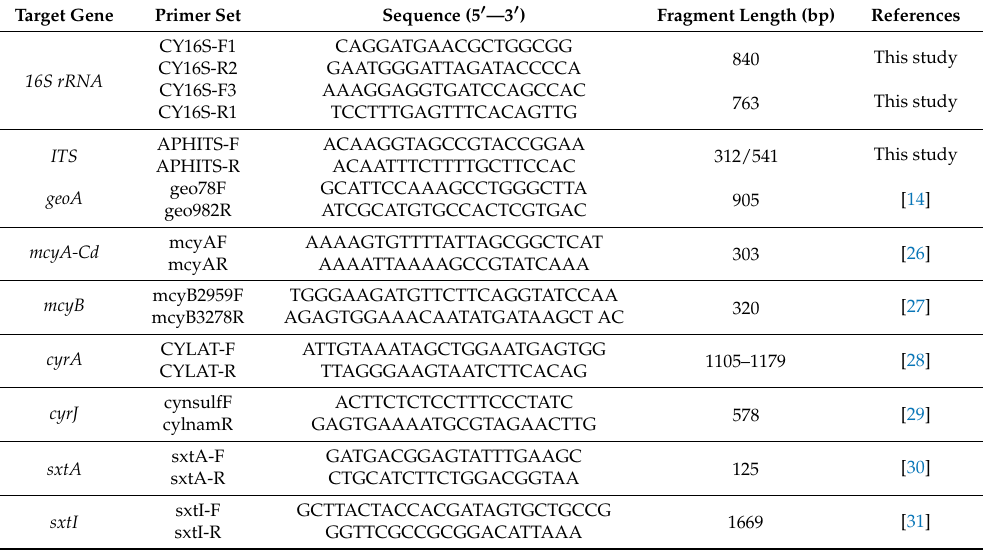
Table 1. List of primers used in this